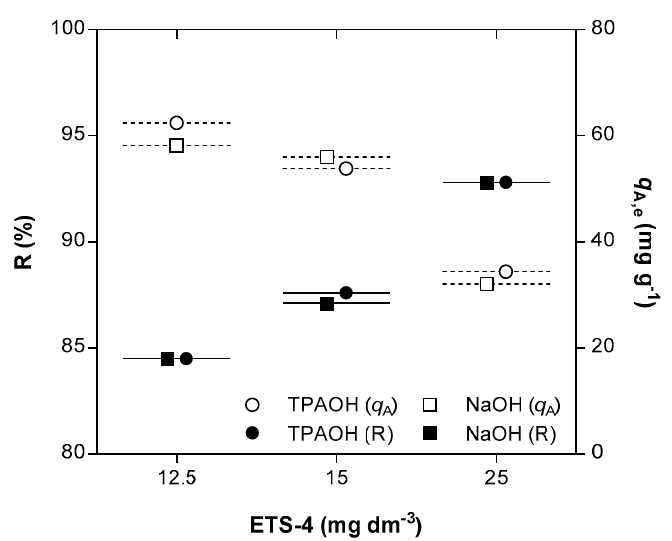
Figure 3. Removal (R) of Hg 2+ (black symbols) and equilibrium concentrations of Hg 2+ in the solid phase ( q A,e ) (white symbols) as function of ETS-4 dose, when using TPAOH (circle) or NaOH (square) as pH adjusting solution. All data refers to the final equilibrium conditions attained.